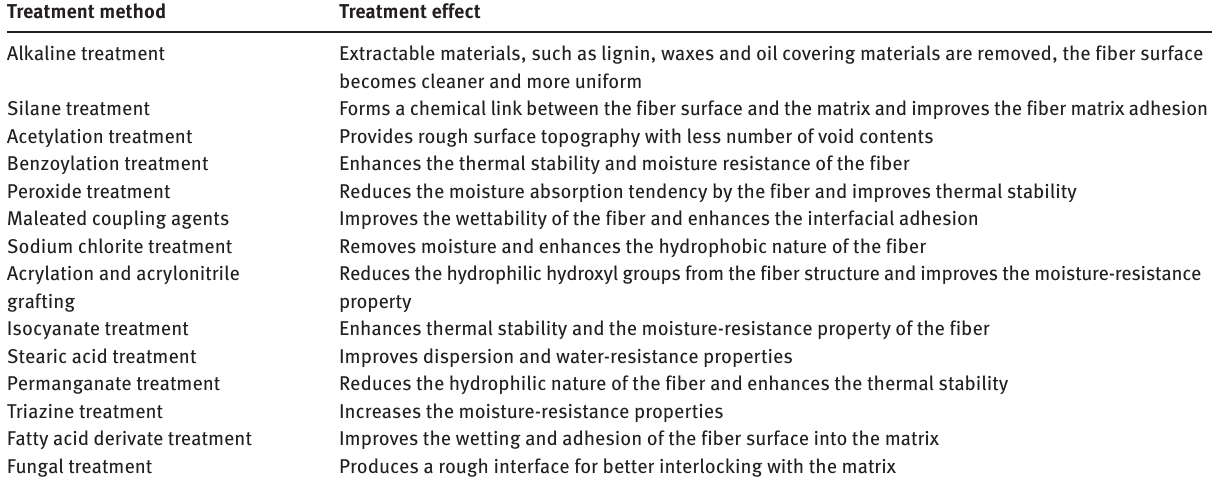
Table 1: The chemical treatments used to process the natural fibers